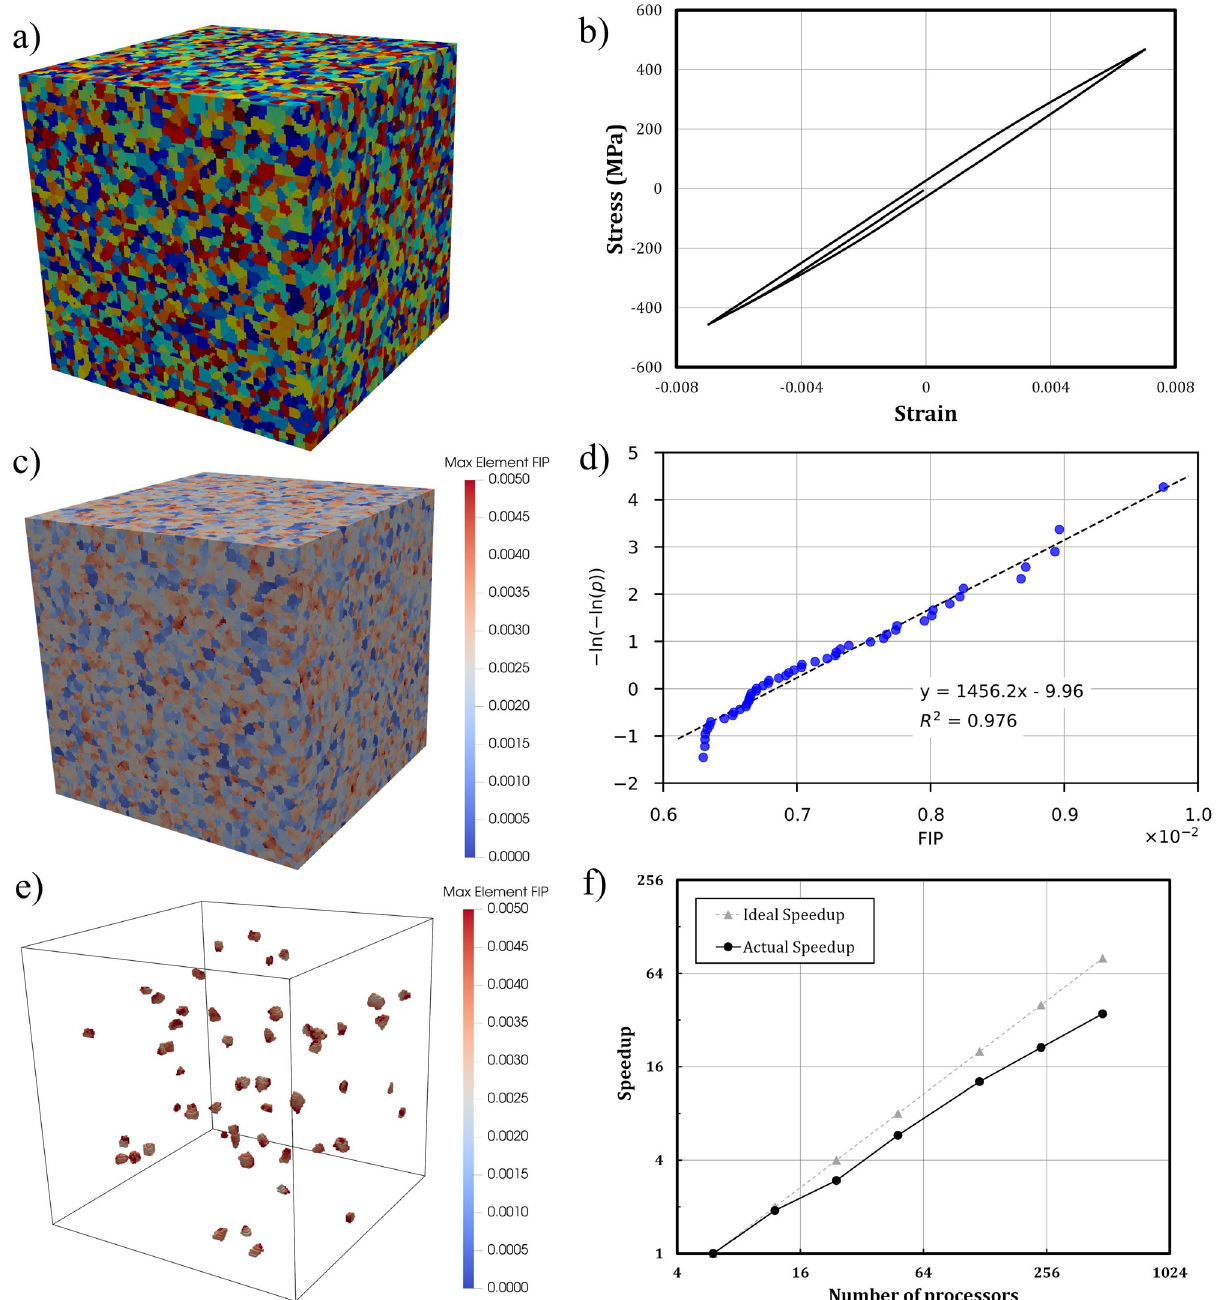
Fig. 1 A large-scale microstructure used to investigate the parallel scalability of PRISMS-Fatigue. a The microstructure with distinct grains shown in different colors. b Macroscopic stress-strain cyclic response. c Variation of elemental Fatigue Indicator Parameters (FIPs) throughout the sample. Although some elemental FIPs are larger than the legend maximum of 0.005, the purpose is to emphasize the heterogeneity of FIPs throughout the sample. d The highest 50 sub-band averaged (SBA) FIPs fi t to the Gumbel Extreme Value Distribution (EVD). e The grains with the highest 50 SBA FIPs. f Strong-scaling CPU Figure 1b shows the cyclic response of the sample during three straining cycles. The variation of elemental FIPs throughout the sample is shown in Fig. 1c. Microplasticity is heterogeneously distributed throughout the microstructure and fatigue crack formation is most probable at hot spots corresponding to high FIP values. Accordingly, the Gumbel EVD of the highest 50 sub- band averaged FIPs is illustrated in Fig. 1d. Furthermore, the grains with the highest 50 sub-band averaged FIPs are presented in Fig.